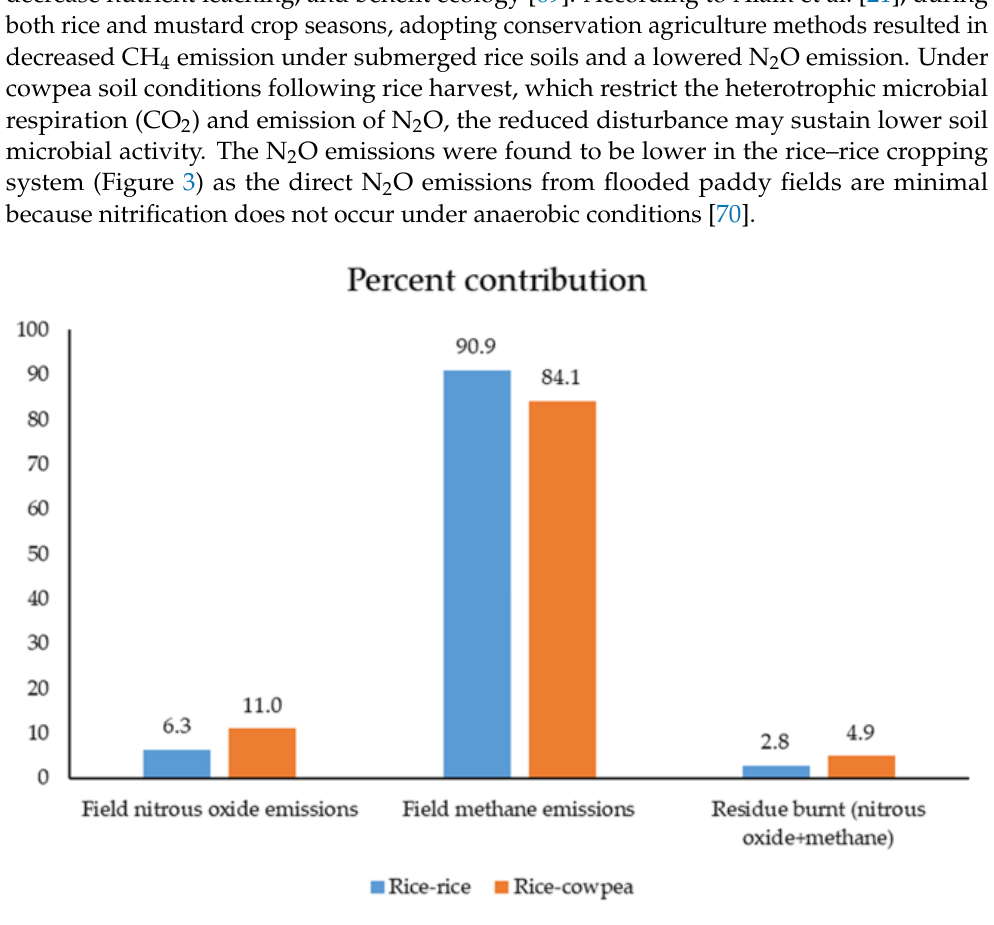
Figure 3. Contribution of different GHG to field emissions (labels are data in kg CO 2